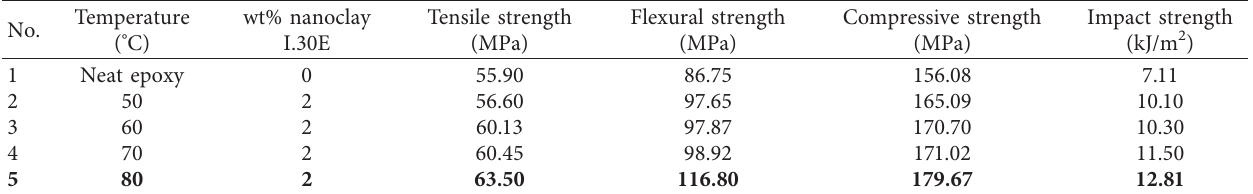
Table 3: Effect of temperature during mechanical stirring on mechanical properties of epoxy Epikote 240/nanoclay I.30E nanocomposite